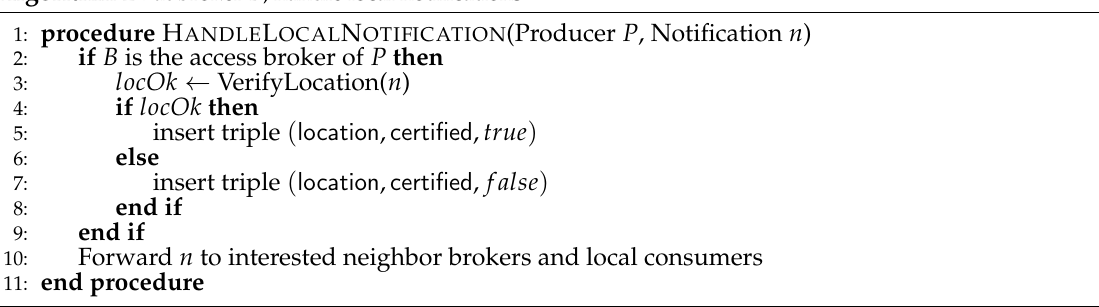
Algorithm 2 : at broker B , handle local